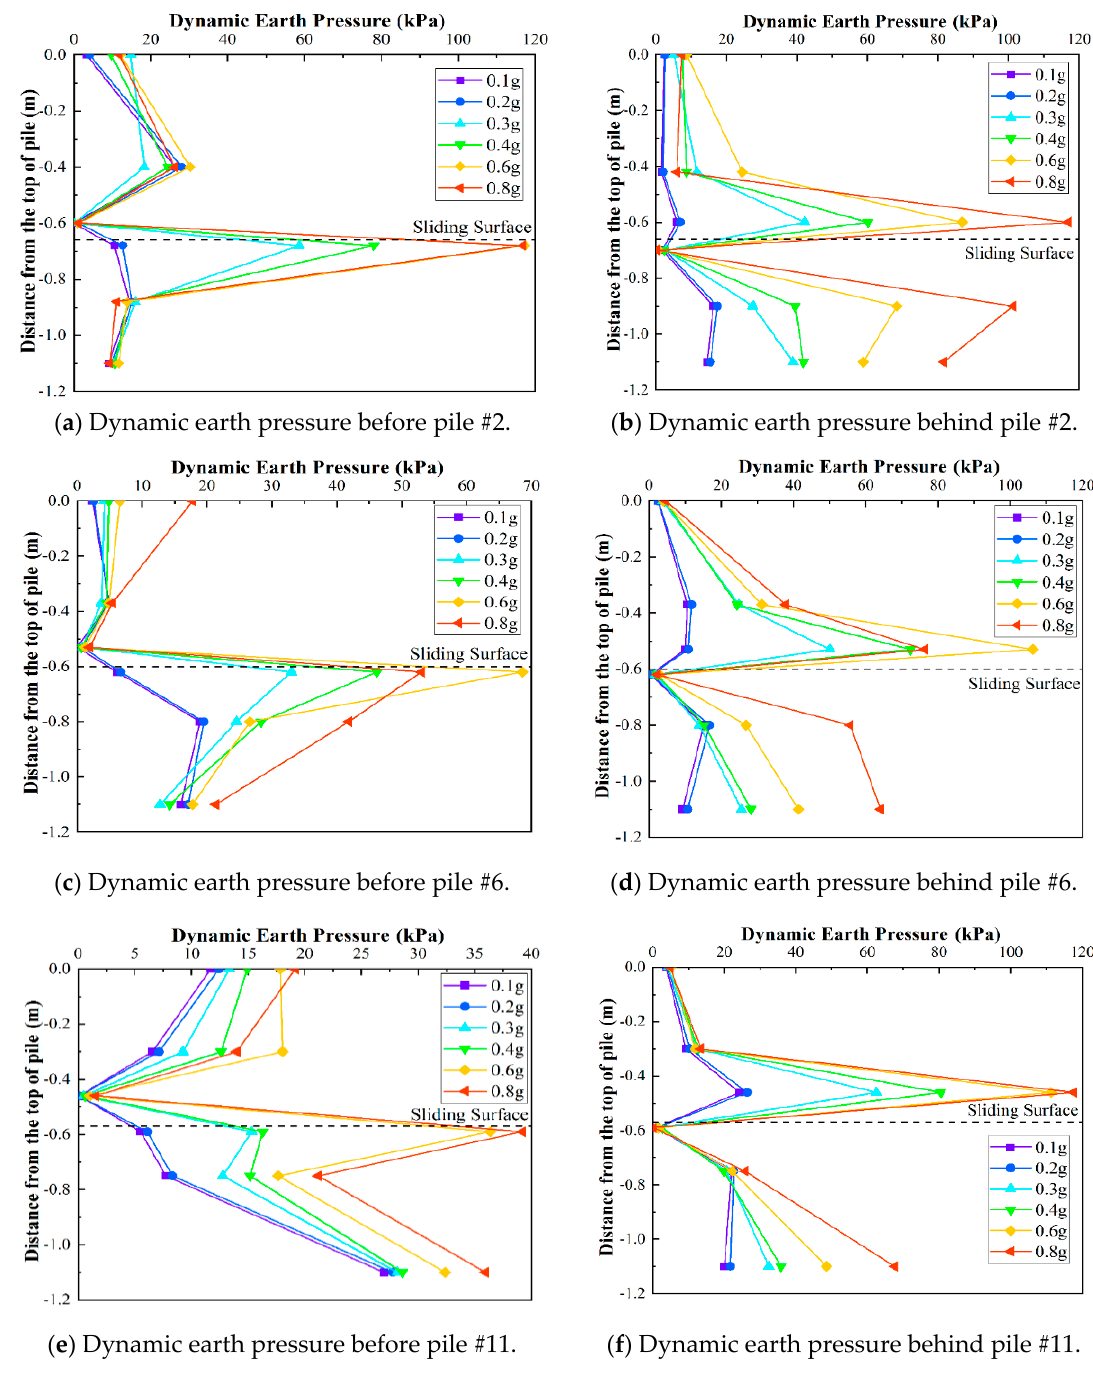
Figure 13. Dynamic earth pressure distribution in front of and behind each row of piles in the dynamic tests.